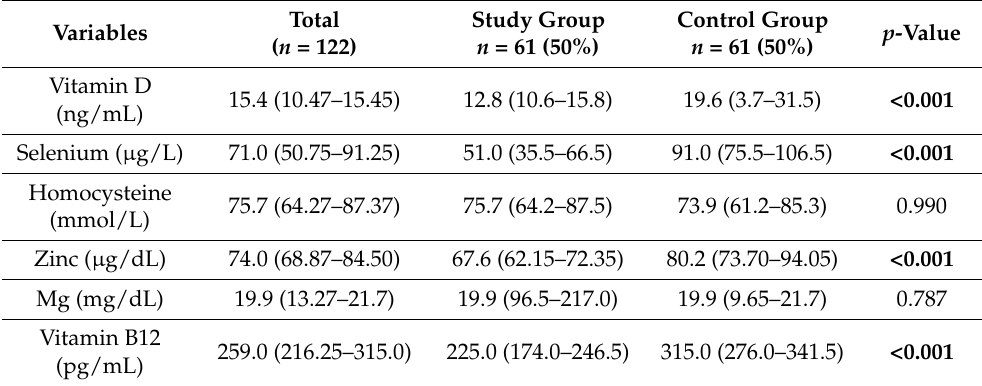
Table 3. Comparison of biochemical parameters of children in the study and control